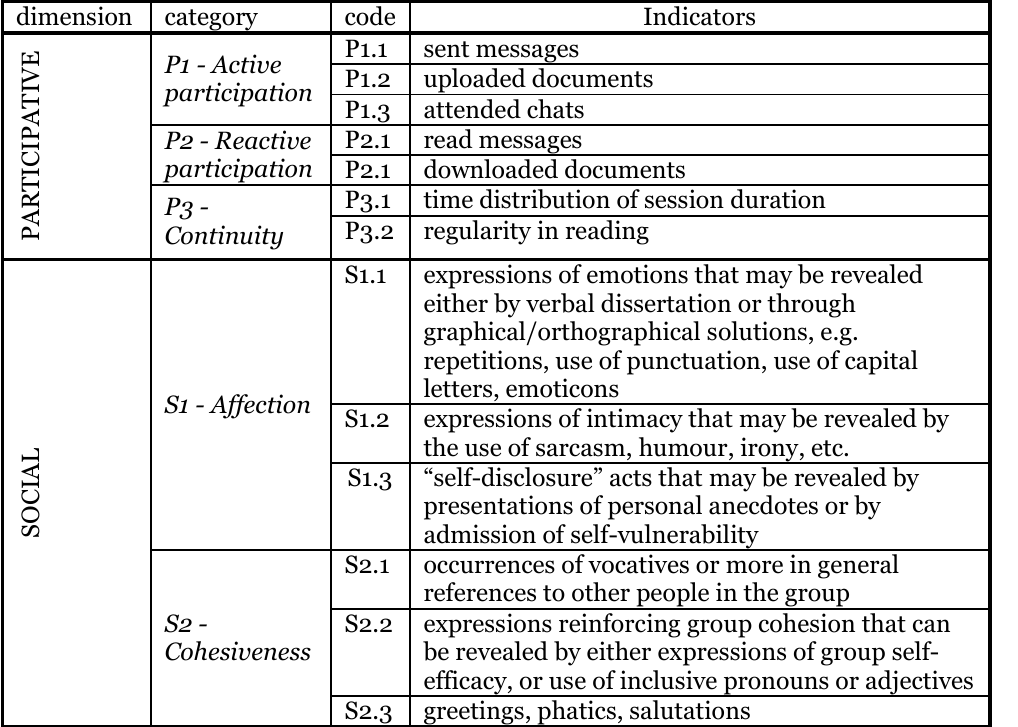
Table 2 Dimensions and Indicators of the Model Adopted (Persico et al., 2010) dimension category code